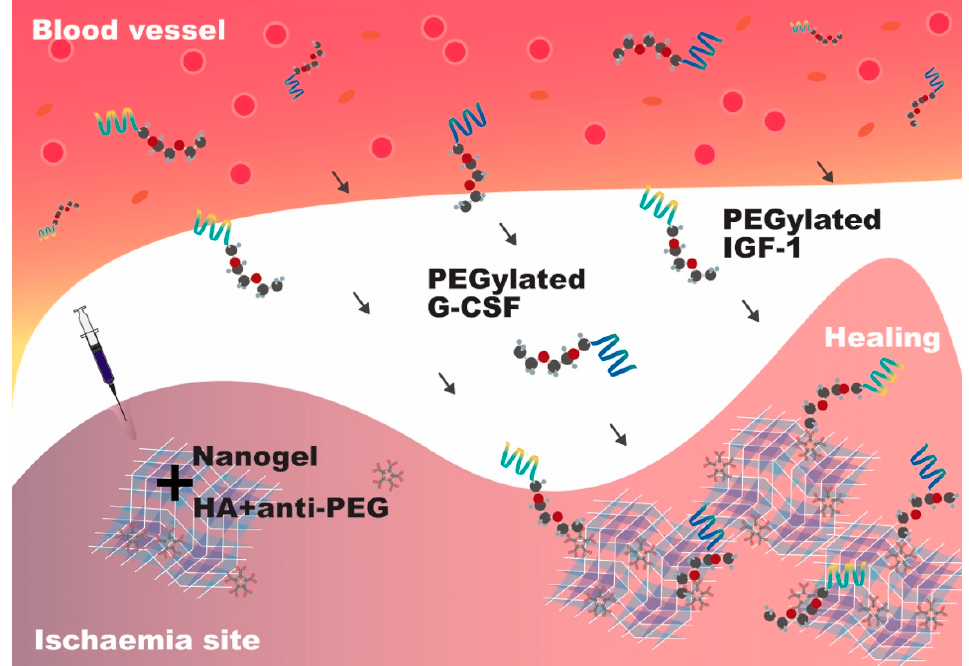
Figure 2. Reloadable multidrug capturing system. The nanogel containing anti-polyethylene glycol (PEG) antibody forms a scaffold which is capable of capturing multiple PEGylated factors from the blood vessel. PEGylated insulin-like growth factor (IGF)-1 is captured and retained, which reduces muscle cell death. Even after capturing the first factor, the reloadable scaffold is still capable of capturing and retaining the second factor, which is PEGylated granulocyte colony-stimulating factor (G-CSF), thereby promoting angiogenesis.